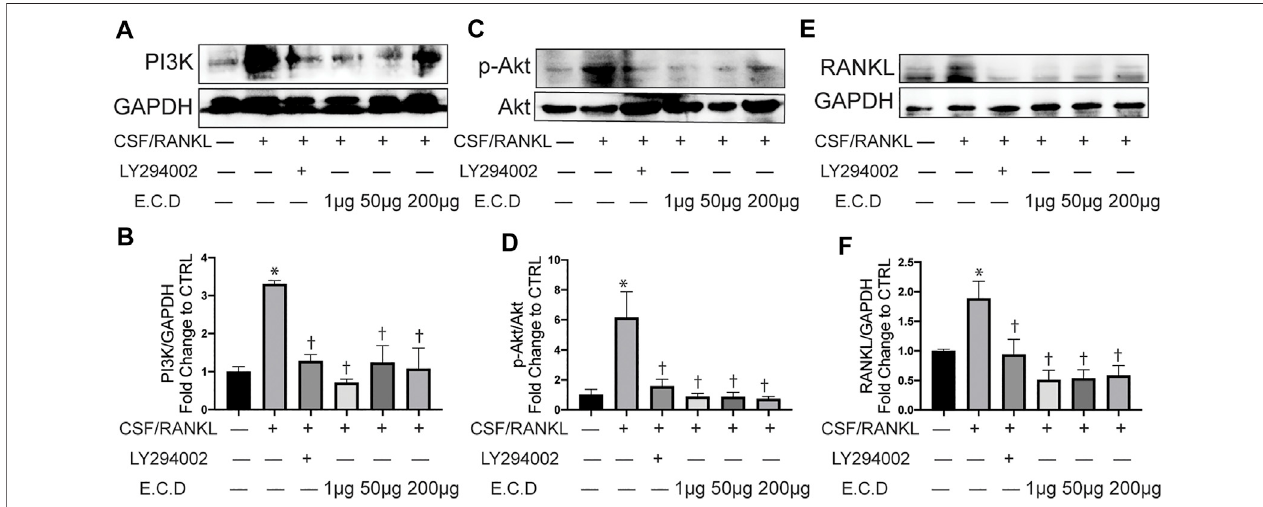
FIGURE 8 | E.C.D. extracts inhibited osteoclast differentiation through regulating PI3k/Akt pathway. PI3K inhibitor (LY294002) was added 2 h before C/R induction. Raw264.7 cells were stimulated with C/R. E.C.D. extracts in different doses (1 μ g/ml, 50 μ g/ml, 200 μ g/ml) were added at the same time for 48 h. (A) Representative Western blotting images of PI3K and GAPDH. (B) Fold changes in relative densitometric values of PI3K. (C) Representative Western blotting images of p-Akt and Akt. (D) Fold changes in relative densitometric values of p-Akt. (E) Representative Western blotting images of RANKL and GAPDH. (F) Fold changes in relativedensitometric valuesofRANKL. n =3,datawasanalyzed asmean±SEM,*vs.CTRLgroup(CSF/RANKL – LY294002 – E.C.D – ), † vs.C/Rgroup(CSF/RANKL + LY294002 – E.C.D – ), p < 0.05.